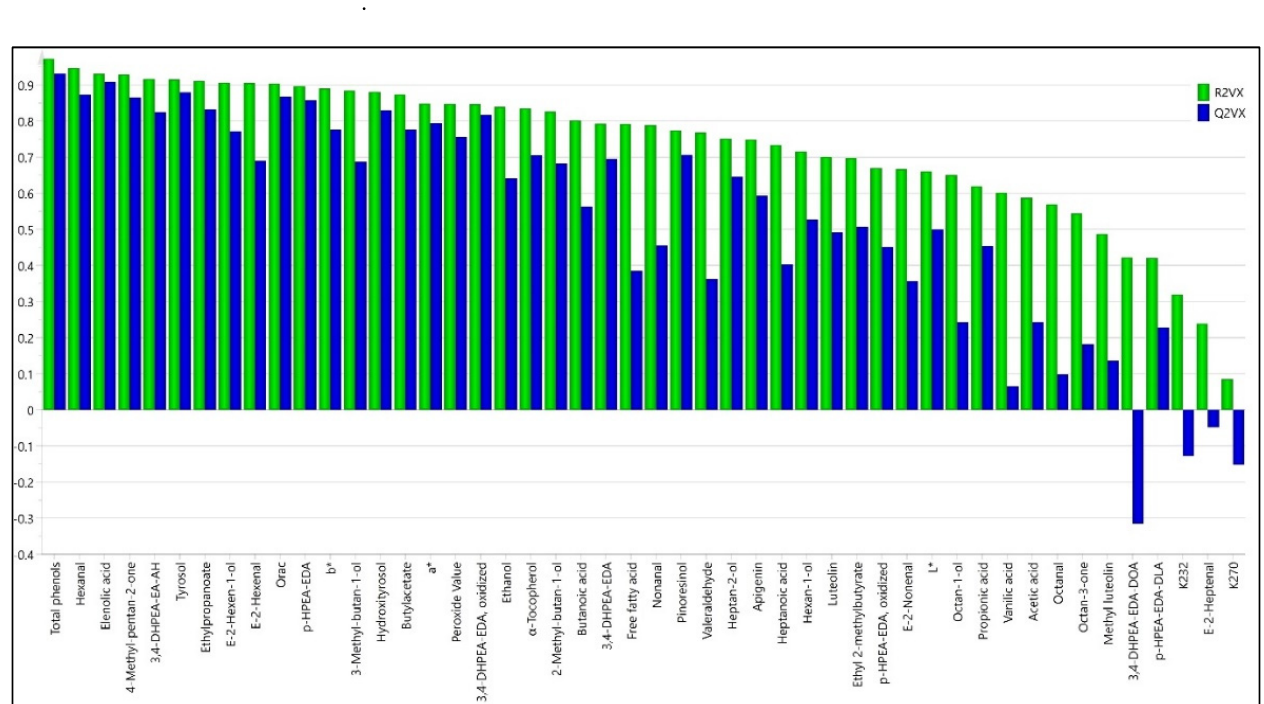
Figure 3. Explained fraction (R 2 VX) of the variation of the X variables (48 phenolic and volatile compounds and physical–chemical parameters) obtained from the virgin olive oil samples.